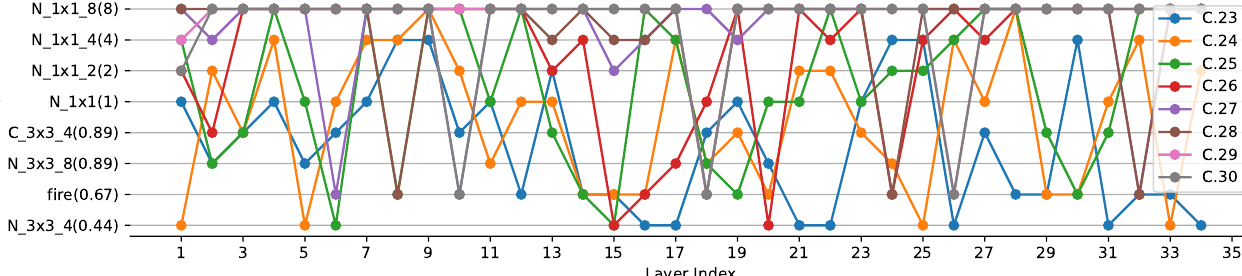
Figure A3. The operator of each layer in compressed MobileMetV2. The layers in the figure do not include the first convolutional layer and the last fully connected layer. The vertical axis has the same meanings as Figure